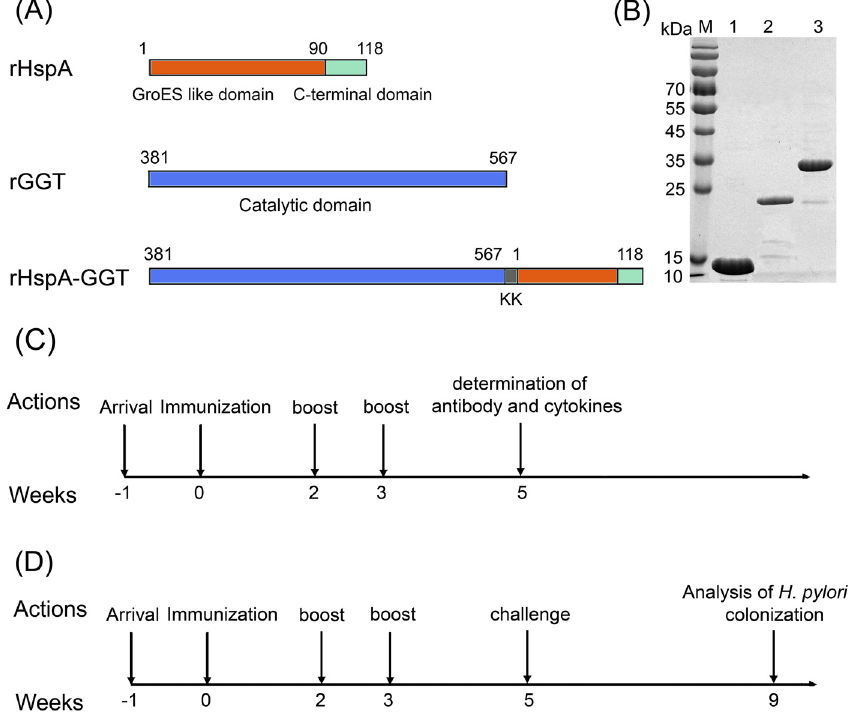
Fig 1. Candidate antigens and immunization schedule used in this study. (A) Three His-tagged recombinant proteins were designed to be used as candidate antigens: full length HspA (rHspA), the catalytic domain of GGT (rGGT), and a fusion protein composed of rHspA and rGGT linked by two lysine residues (rHspA-GGT). (B) Recombinant proteins were purified by nickel ion affinity chromatography and